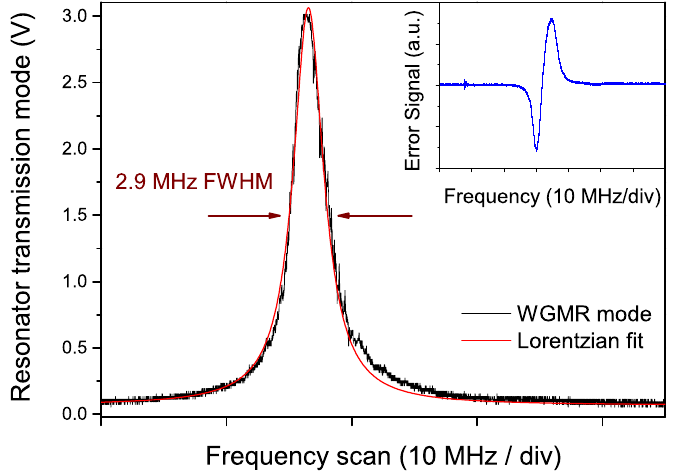
Figure 3. Resonator transmission mode corresponding to a temperature of ∼ 34.5 ◦ C. The trace was acquired with a scan time duration of 50 ms. The fitting Lorentzian curve is shown in red. Inset: error signal at the mixer output (modulation frequency 3.5 MHz, modulation depth ∼ 5